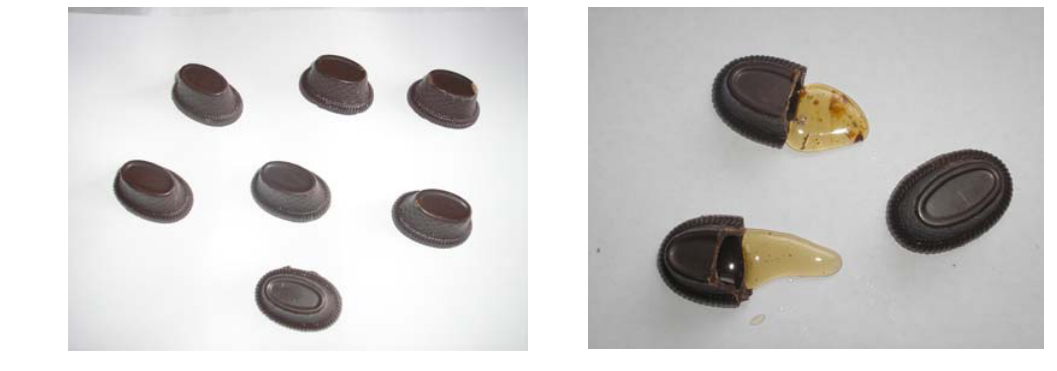
Figure 1. Visual appearance of hand made pralines with different bee-product fillings after 180 days of storage at ambient temperature.